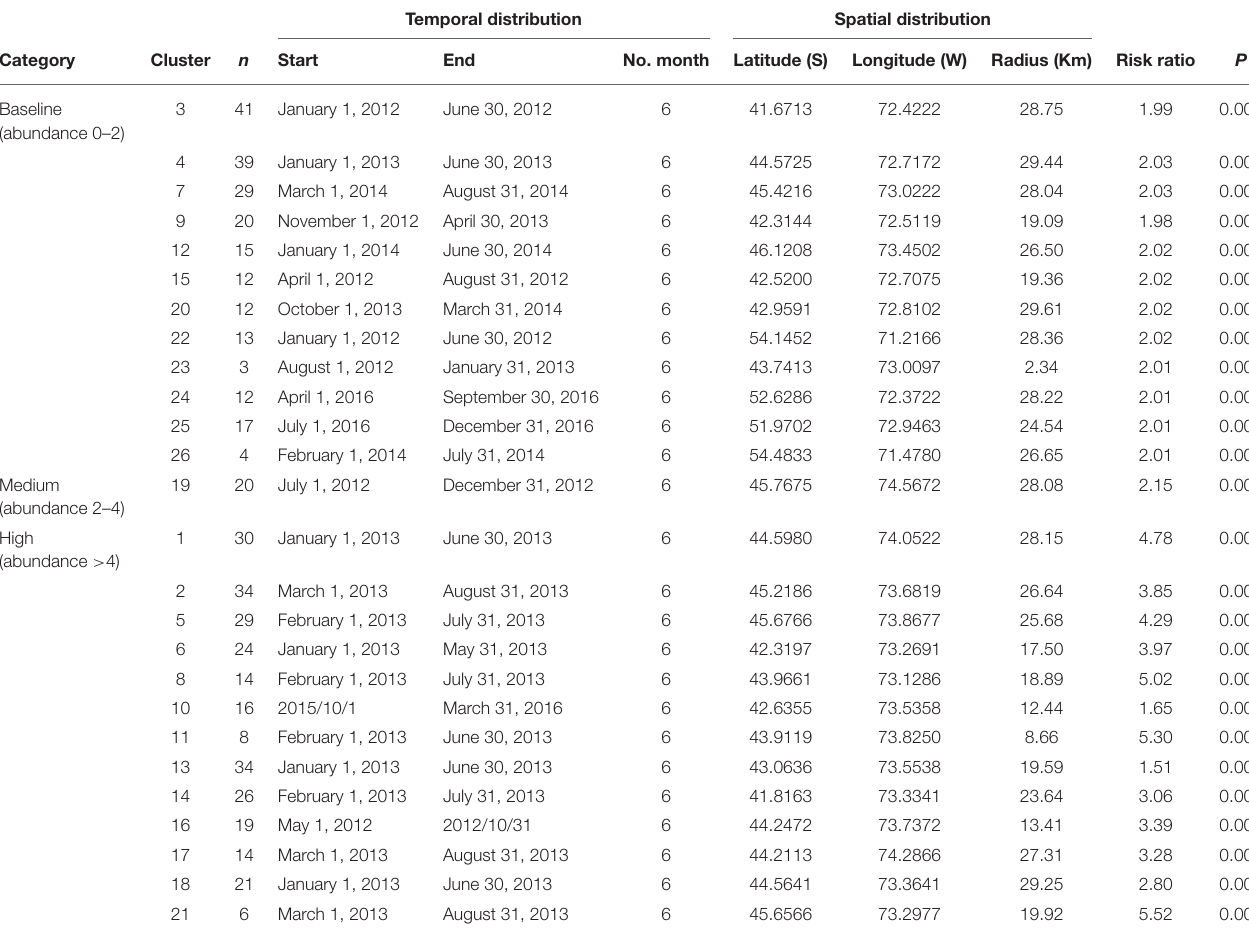
TABLE 1 | Clusters of Caligus rogercresseyi detected and their risk ratios from 2012 to 2016 in Region X [Los Lagos], Region XI [Aysén], and Region XII [Magallanes] of Chile. Temporal distribution Spatial